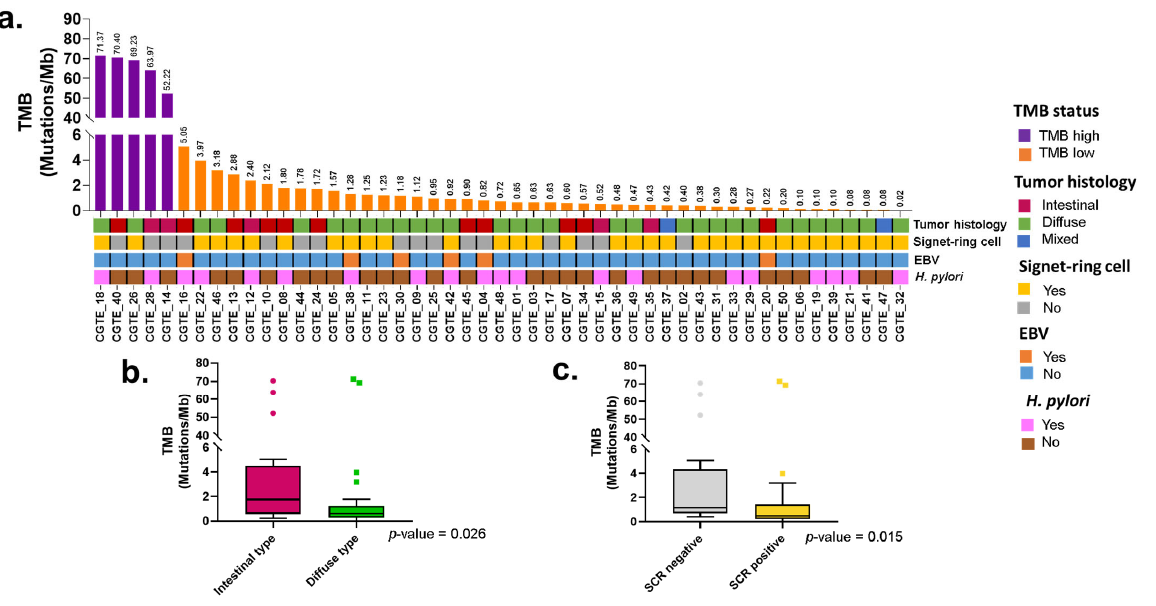
Figure 1. Tumor mutational burden of gastric adenocarcinoma in patients treated at The Instituto Nacional de Cancerología of Mexico between January 2019 and January 2020 (n = 49). ( a ) Tumoral mutational burden (TMB) across the sequenced samples. TMB was calculated with all the variants affecting the coding region. Purple bars indicate high TMB, and orange bars indicate low TMB. TMB ≥ 10 mutations/Mb was considered as high TMB. The lower panel represents the clinical features of the patients including tumor histology, signet ‐ ring cell presence, Epstein–Barr virus (EBV) presence, and Helicobacter pylori ( H. pylori ) infection. ( b ) Comparison of TMB value according tumor histology. ( c ) Comparison of TMB value according to the presence of signet ‐ ring cell. p ‐ values were calculated using Kruskal–Wallis test.